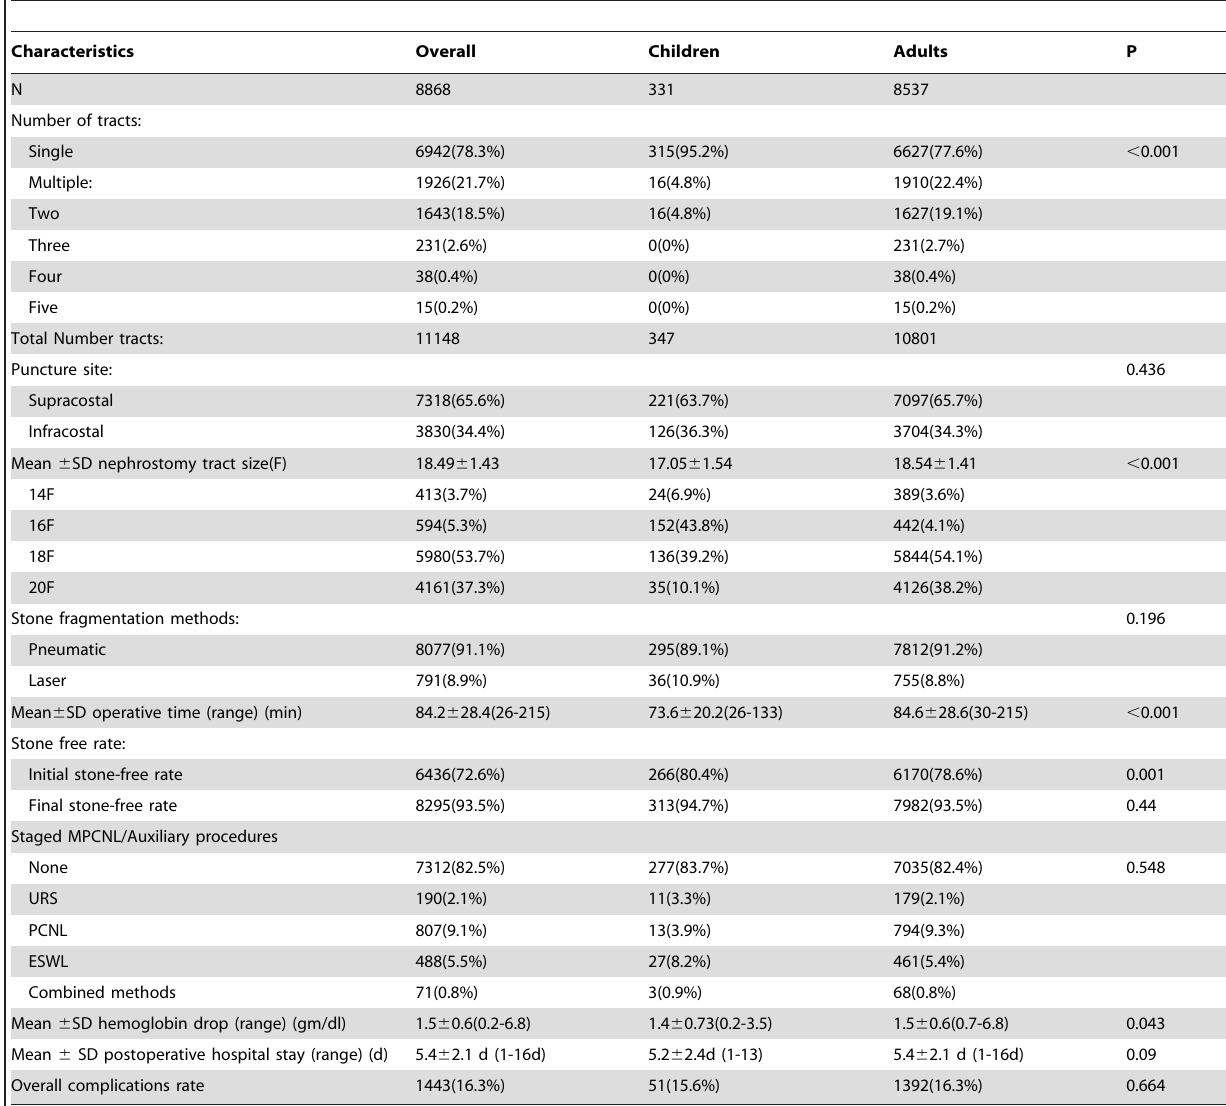
Table 2. Operative